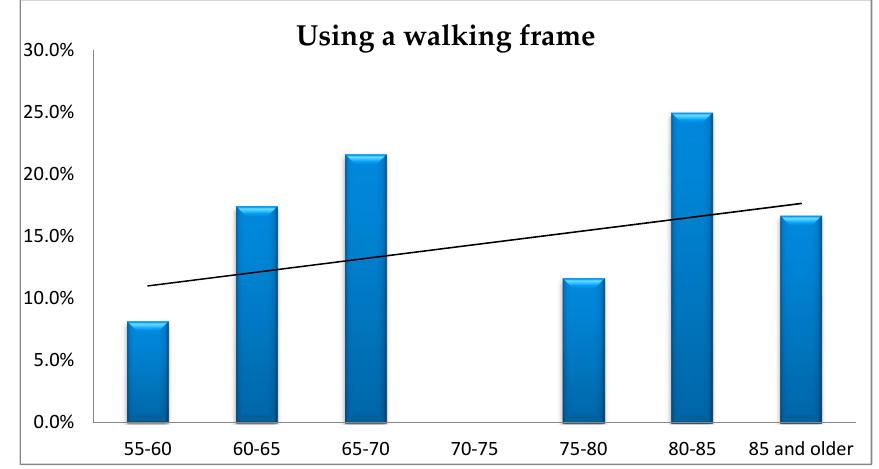
Figure 7. The respondents’ age vs. using a walking frame.